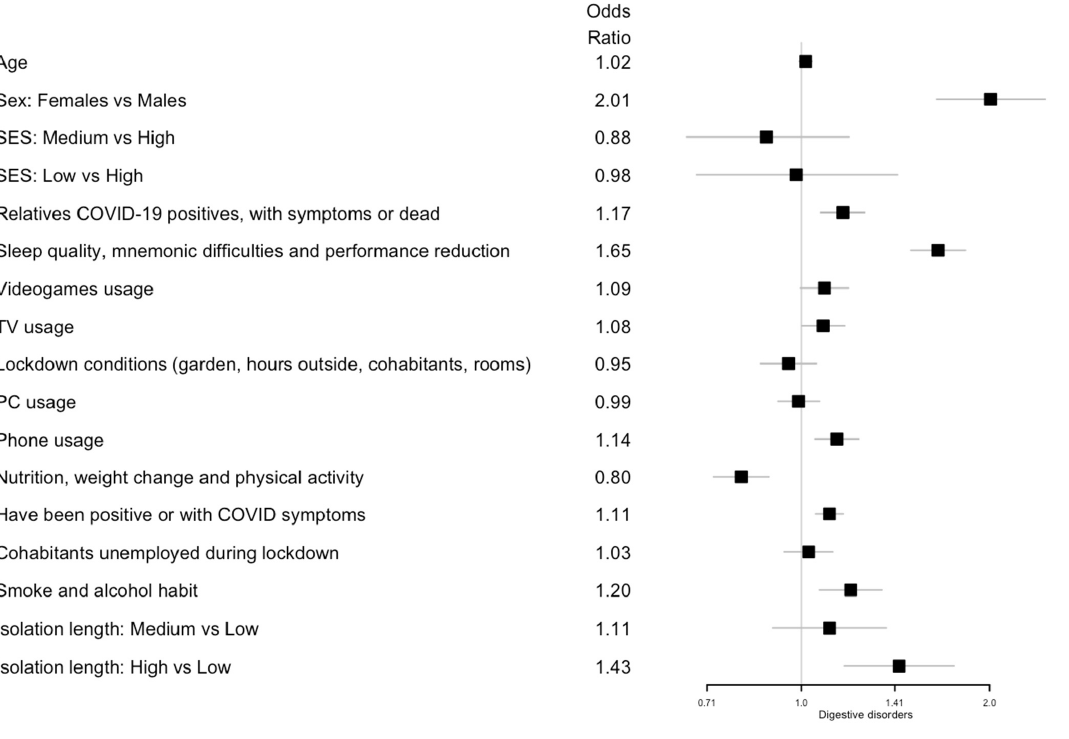
Figure 1. Forest plots for the effect of the covariates on digestive disorders. The squares represent the odds ratios and the lines depict the confidence intervals estimated by the logistic regression.